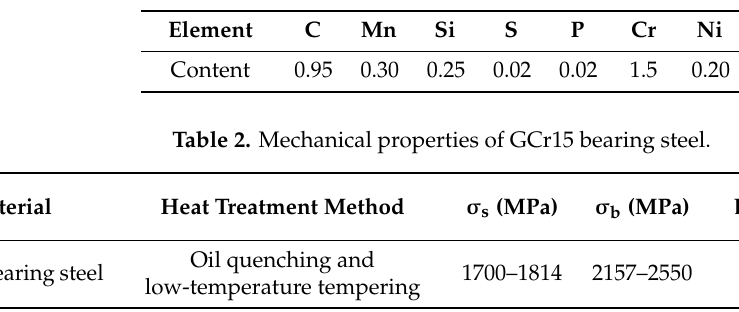
Table 1. Composition of bearing steel.